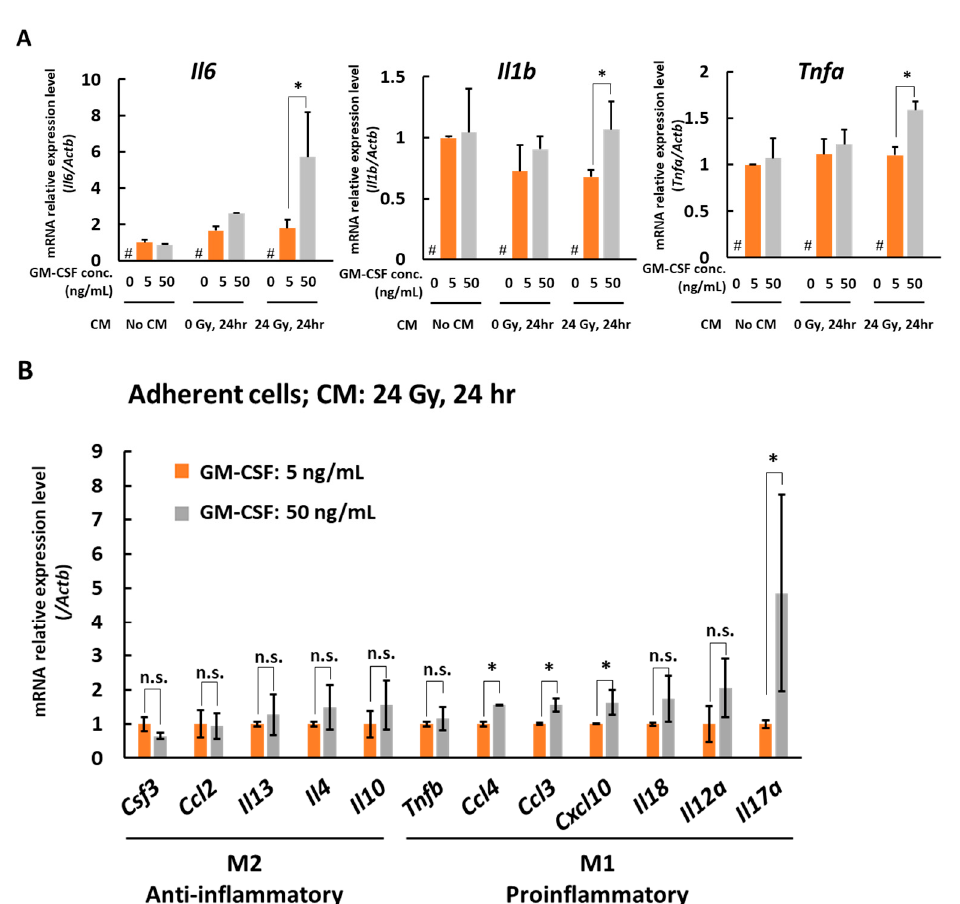
Figure 4. Real-time PCR analysis of the expression of type 1 macrophage markers and cytokine genes expression profiles in adherent cell fractions. ( A ) mRNA expression level of macrophage type 1 markers, Il6 , Il1b , and Tnfa . Bone marrow cells on day 6 after culture with different concentrations of GM-CSF and CM obtained from non-irradiated or 24 h after 24 Gy γ -irradiated B16 cells. Mean ± SE, n = 3. *, p < 0.05. #, no living cells. ( B ) The cytokine gene expression profiles related to type 1 and type 2 macrophages. Adherent cells obtained from bone marrow cells on day 6 after culture with different concentrations of GM-CSF and CM obtained 24 h after 24 Gy γ -irradiated B16 cells. Mean ± SE, n = 3. *, p < 0.05. n.s., no significant difference.